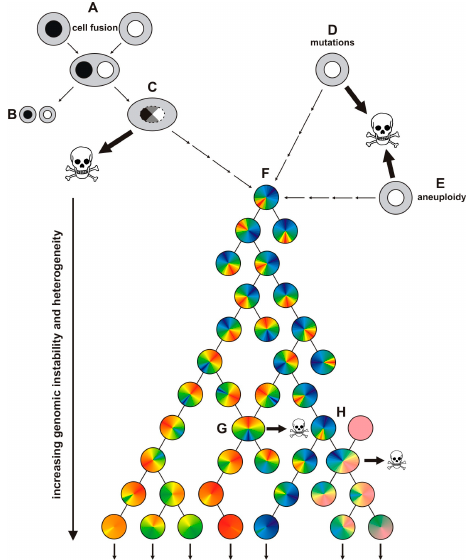
Figure 2. Induction of a mutator phenotype in cancer cells by cell fusion, mutation or aneuploidy. Cell fusion first result in heterokaryon formation ( A ); Such cells either remain in the heterokaryon state or could undergo ploidy reduction resulting in two daughter cells ( B ); However, in some cells cytogenesis might be defective causing the merging of the parental chromosomes (so-called heterokaryon-to-synkaryon transition) ( C ); Most of these hybrids will die because of activation of tumor suppressor genes, but a few cells will be able to survive and proliferate. Cell fusion, like mutations ( D ) and aneuploidy ( E ); is a potent inducer of genomic instability and could initiate a mutator phenotype in cancer cells ( F ) ultimately giving rise to phenotypically different genomic unstable cancer cells. Further cell fusion events could occur during tumor progression, whereby tumor cells and tumor cells ( G ) as well as tumor cells and other cells could fuse ( H ), thereby promoting the heterogeneity of the tumor